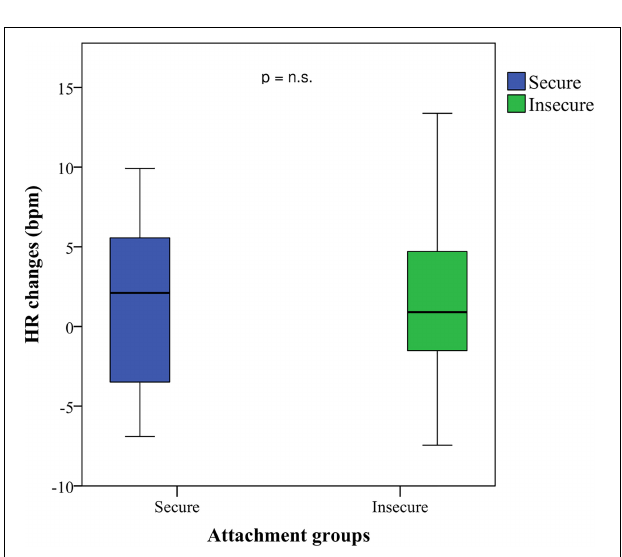
FIGURE 2 | RMSSD changes of adolescents classified as secure and insecure from the total baseline to the attachment interview.